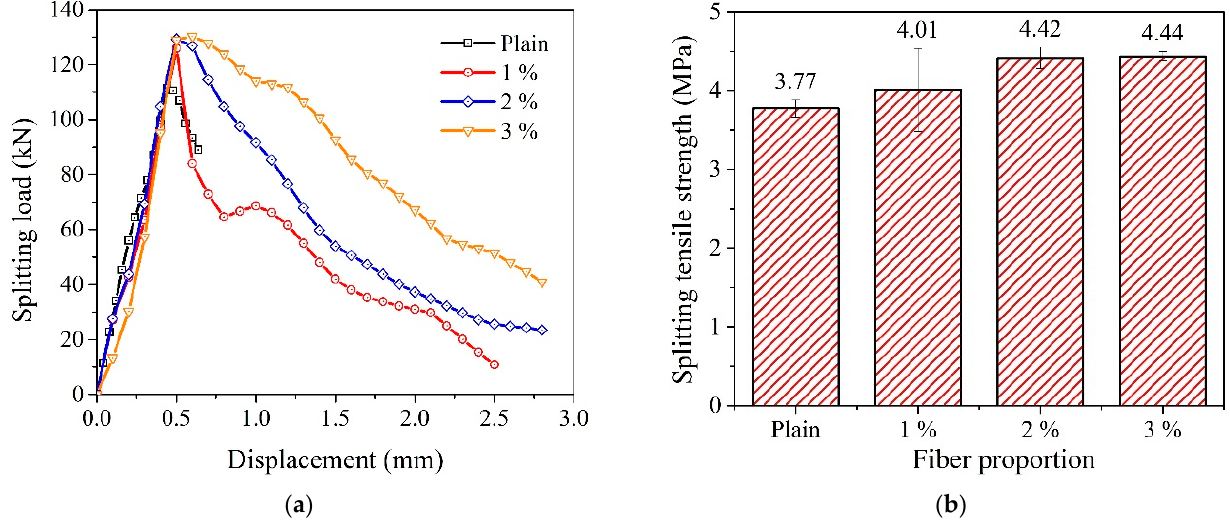
Figure 8. Splitting tensile strength test results: ( a ) Splitting load–displacement curves; ( b ) splitting tensile strength.